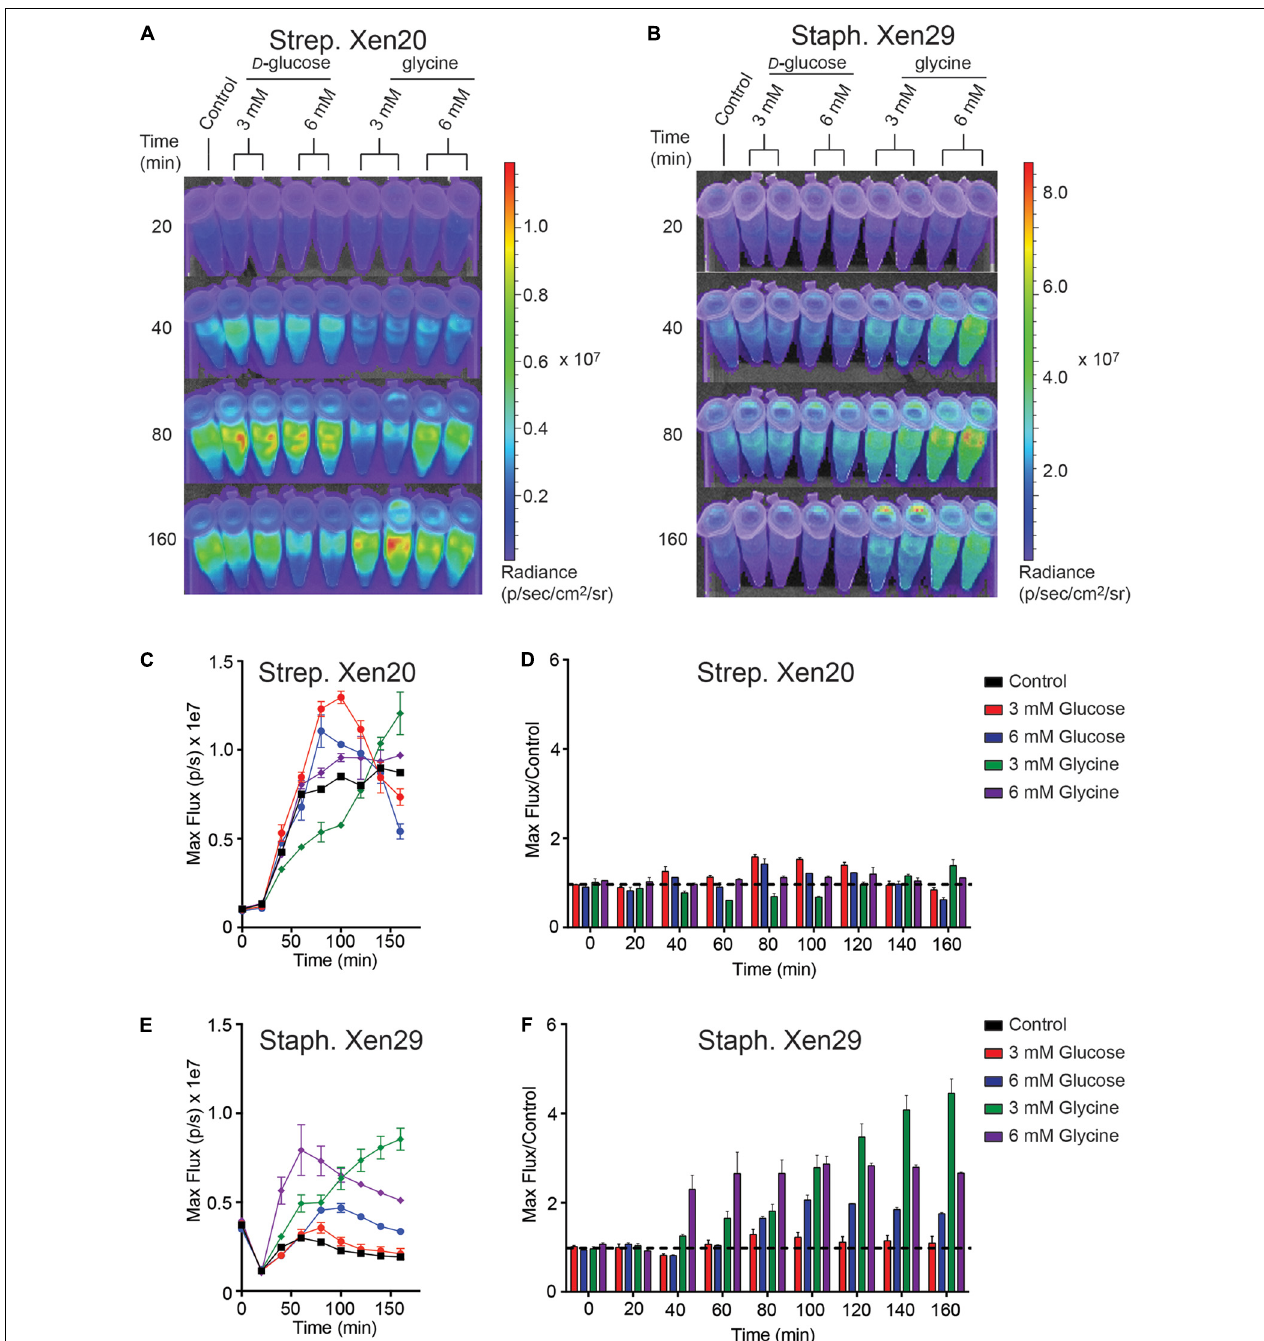
FIGURE 5 | Increased luminescence production by Gram-positive pathogen incubated in M9 medium supplemented with casein hydrolysate and yeast extract. OD 600 nm and luminescence were measured using a Thermo Fischer VarioSkan plate at 20 min intervals over 160 min at a constant 37 ◦ C. (A) Representative time course of Strep. Xen20. For all samples, cells were grown to stationary phase then diluted in fresh M9 medium containing casein hydrolysate and yeast extract (i.e., control) supplemented with either D -glucose or glycine as indicated. (B) Similar time course for Staph. Xen29. (C,D) Quantification of the Strep . Xen20 luminescent signal from (A) represented as either the maximum rate of photons per second (max flux) and as the relative maximum signal normalized to the control (shown on the right as flux/control) displayed as a function of time. The black dashed line indicates a ratio at the threshold of 1.0. (E,F) Similar quantification of panel (B) for Staph. Xen29. All samples are color coded as indicated and the experiment performed, as shown in the “Materials and Methods” section.